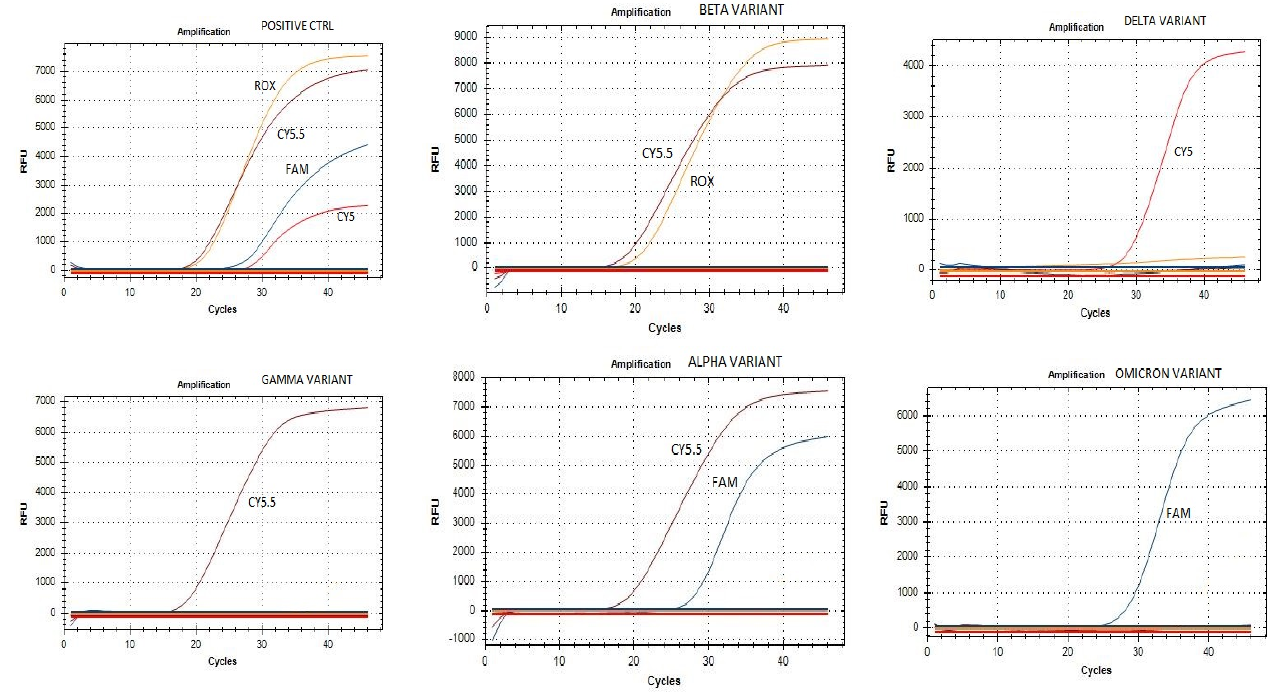
Figure 3. Specificity test of our assay.